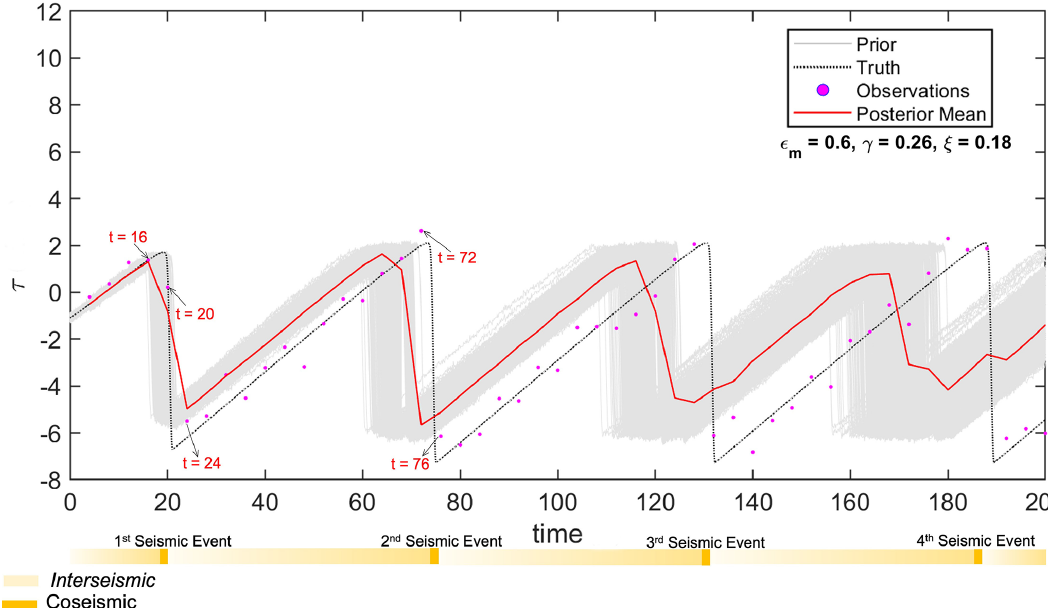
Figure 4. Shear-stress evolution. The coseismic and interseismic phases in the seismic cycle have been highlighted. The time points discussed in the study are t = 16 , 20 , 24 , 72 and 76 in the interseismic phase and t = 20 in the coseismic phase.